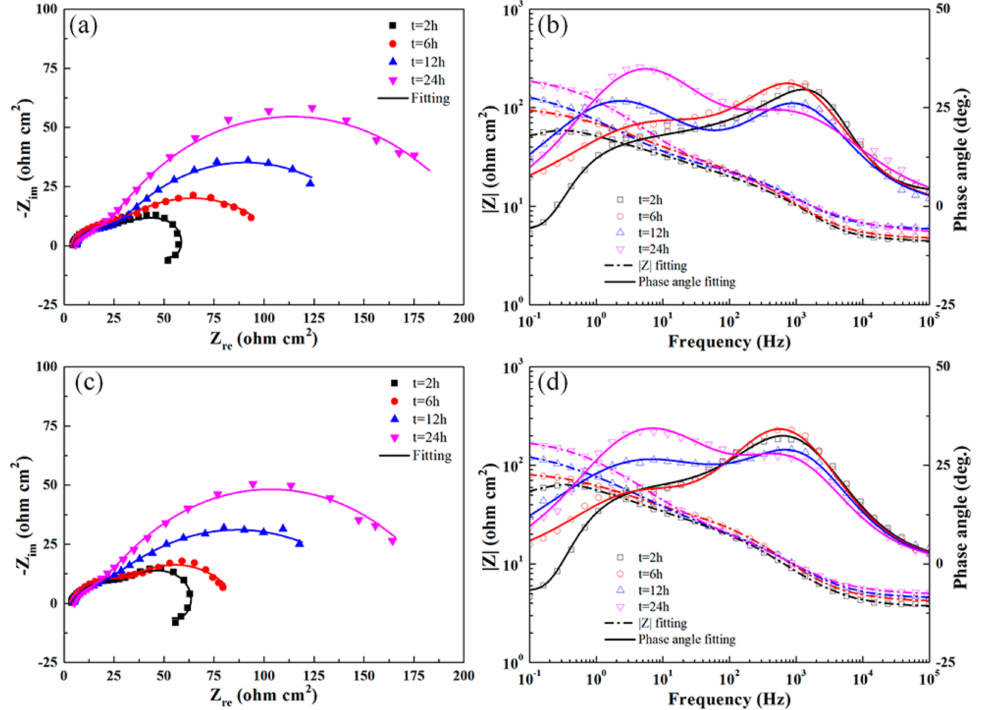
Figure 11. Nyquist ( a , c ) and Bode ( b , d ) plots obtained for UR12-P and UR12-PR samples immersed for di ff erent times in the test solution at OCP.